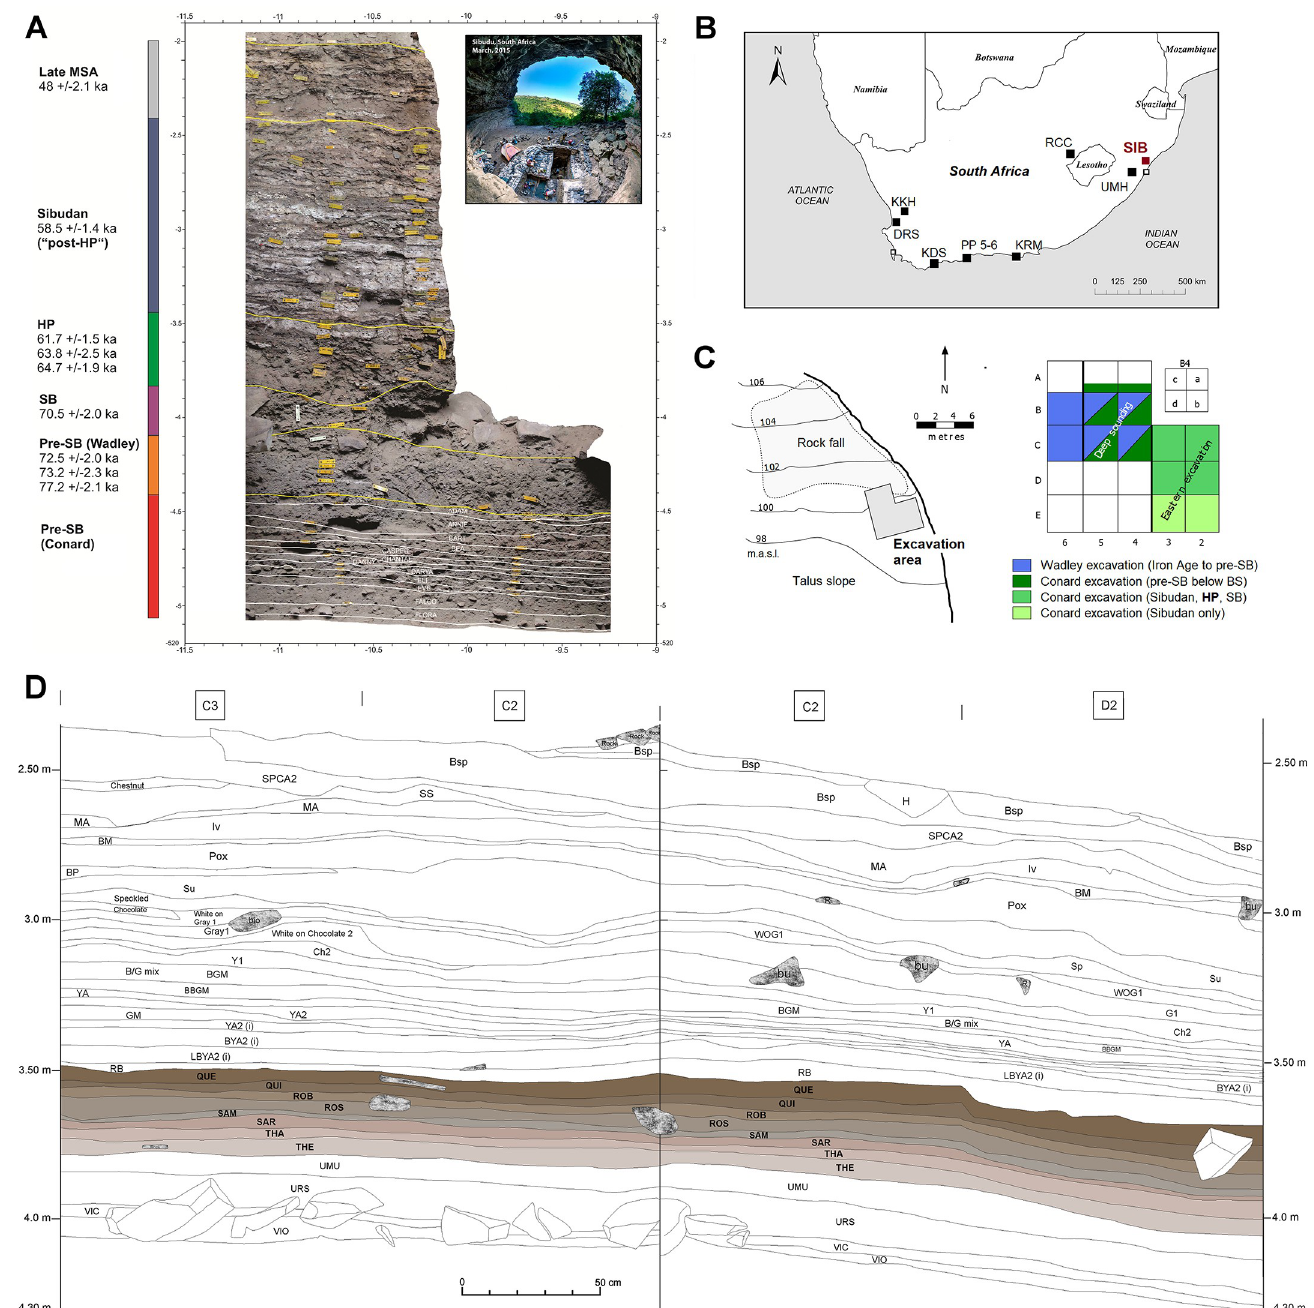
Fig 1. The site of Sibudu. A) Composite stratigraphy with indication of chronometric ages and cultural attributions (2D georectified photomosaic created with Agisoft Metashape of photos taken by Mohsen Zeidi in 2018 with a Nikon Coolpix P510 digital camera in daylight, not color-corrected); B) Geographical map of Sibudu (SIB) and comparative HP sites. C) Horizontal plan of the rockshelter floor and excavation grid, with indication of the Wadley and Conard excavations in different vertical levels. D). Stratigraphic section of the Eastern Excavation (combined north and east profile) of Sibudu with all HP layers (THE-QUE) excavated during 2016–2018 indicated in color. (Figure by V.C. Schmid, M. Zeidi, M. Haaland, A. Val and M.